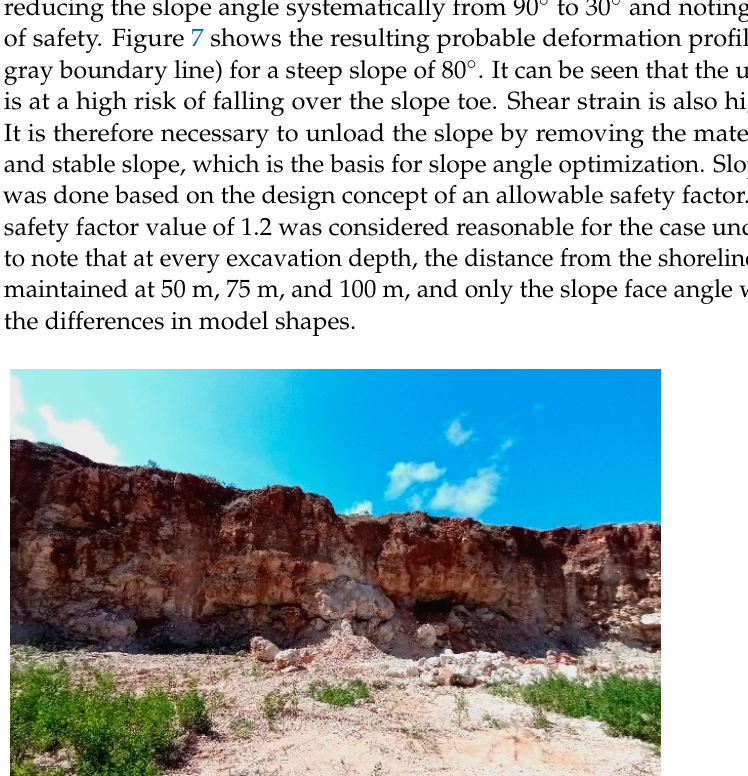
Figure 7. ( a ) Dimension and mesh of slope at 80° angle; ( b ) probable resultant deformation of steep quarry slope. (a) (b)